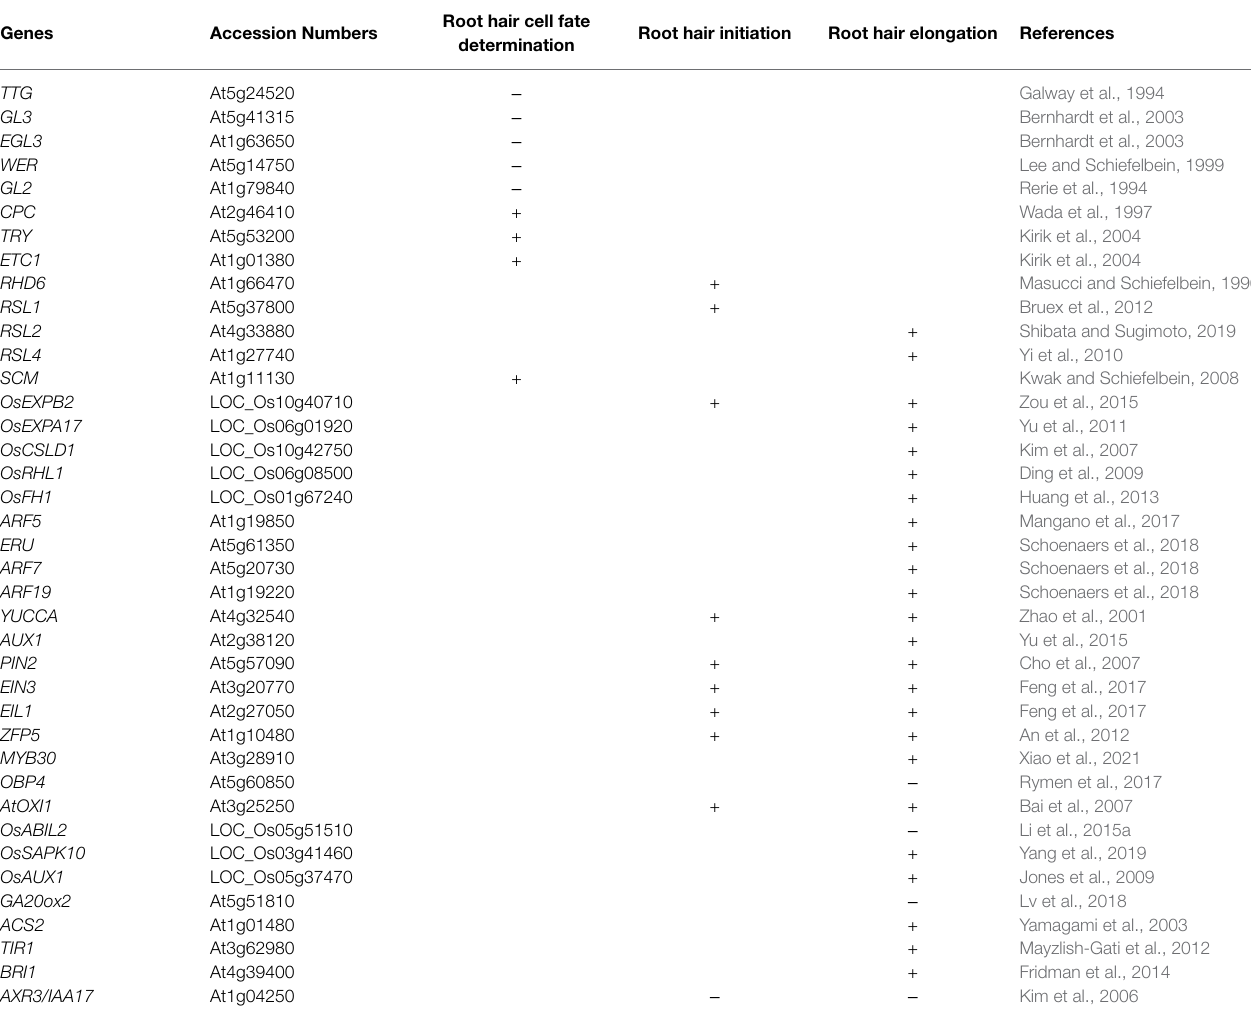
TABLE 1 | The root hair growth and development-related genes in Arabidopsis and rice. –, negative regulation; +, positive regulation.